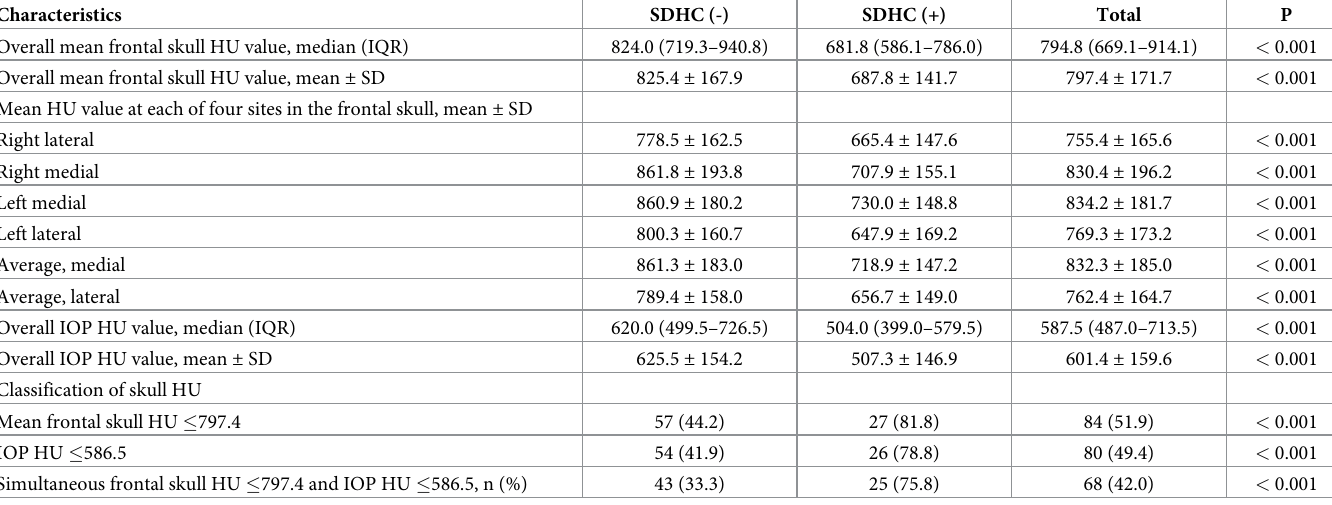
Table 2. Descriptive statistics of frontal and IOP HU values in the study cohort classified according to shunt-dependent hydrocephalus.